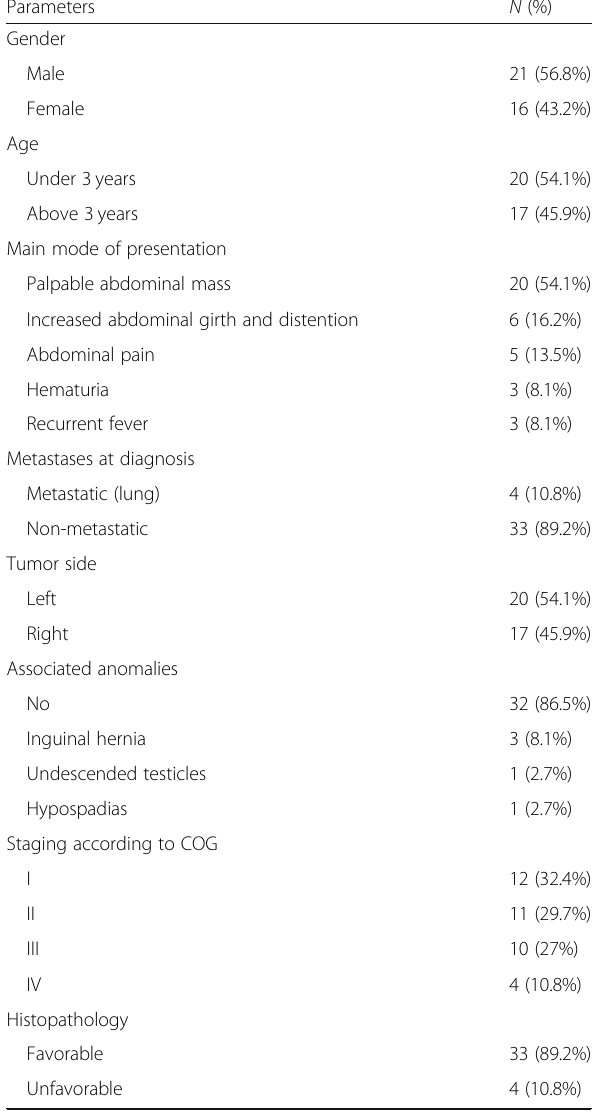
Table 1 The patients ’ demographics, clinical characteristics, and staging